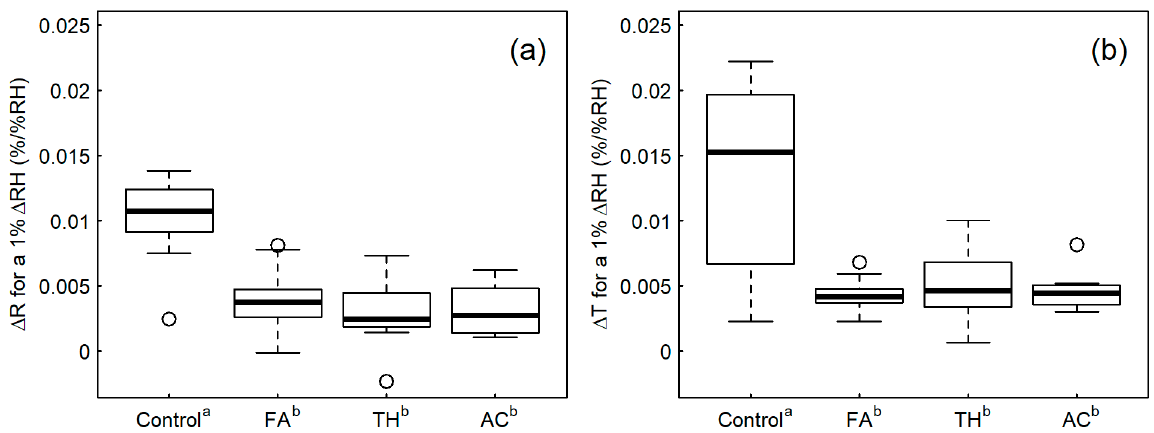
Figure 8. Percentage change in ( a ) radial and ( b ) tangential direction after 24 h at 90% RH for a 1% change in RH. Superscripted letters on the x -axis indicate significant differences according to Tukey’s HSD test (95% confidence level).